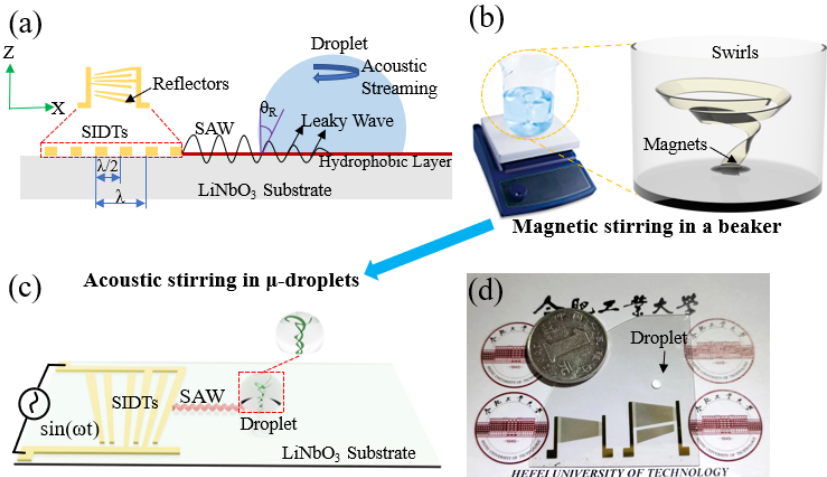
Figure 1. ( a ) Working principle of SAWs propagation and the generation of acoustic streaming. ( b , c ) Schematic diagram of acoustolfuidic µ- droplets stirring method for updating magnetic stirring in a ( b , c ) Schematic diagram of acoustolfuidic µ -droplets stirring method for updating magnetic stirring beaker. ( d ) Optical image of the fabricated acoustic microdevices. in a beaker. ( d ) Optical image of the fabricated acoustic